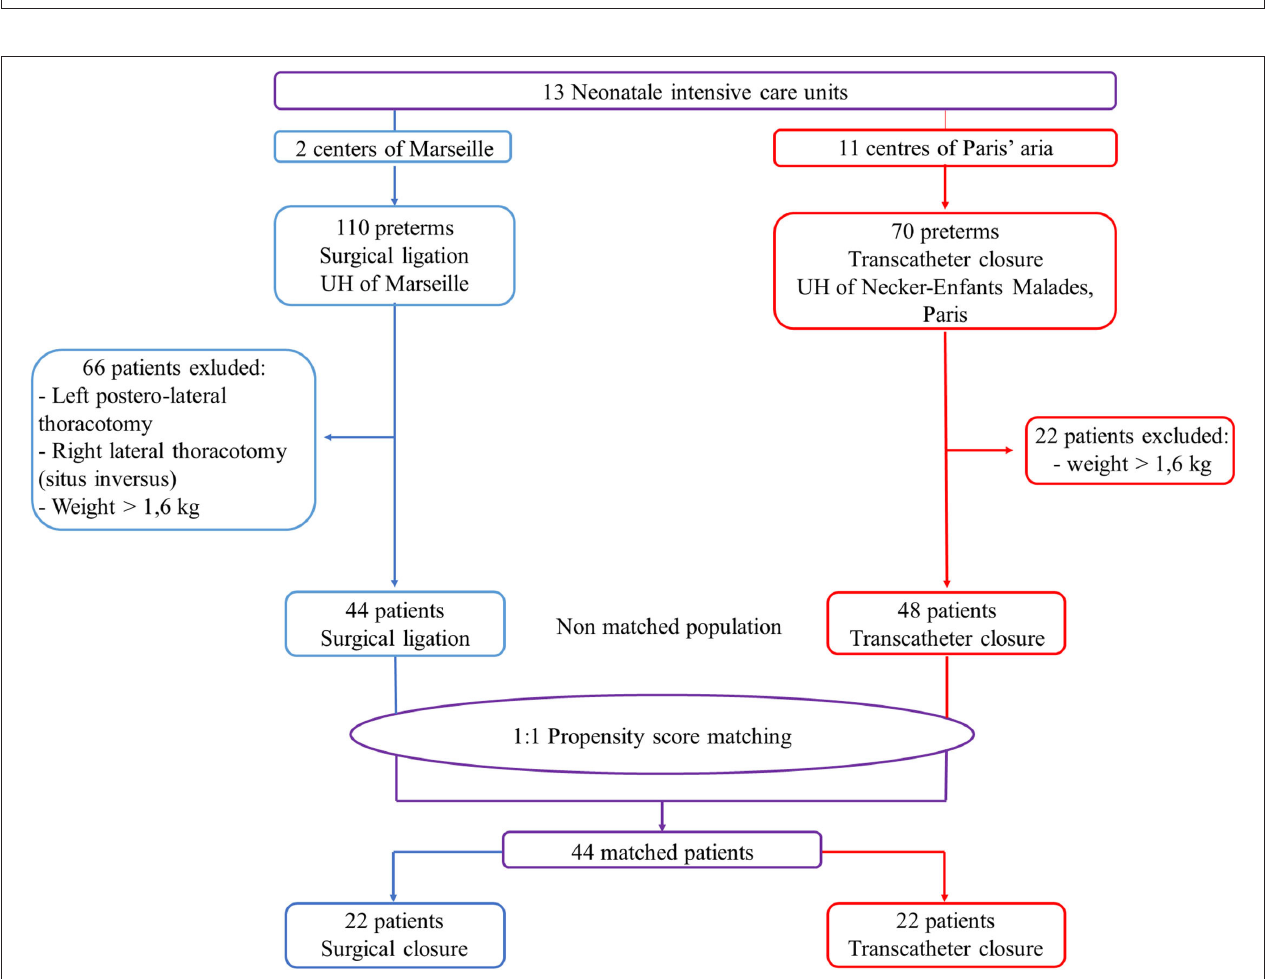
FIGURE 2 | Flowchart of the surgical and transcatheter patients.